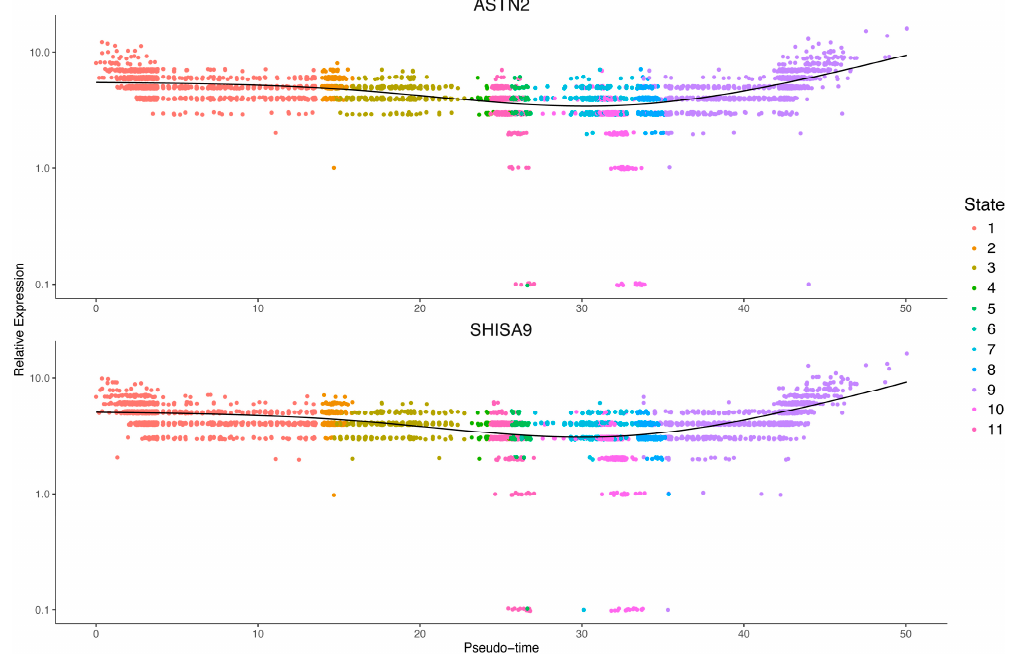
Figure 10. Analysis of gene expression trend. The X-axis is the pseudotime value, and the Y-axis is the expression value. The time states of the cells are shown in different colors.